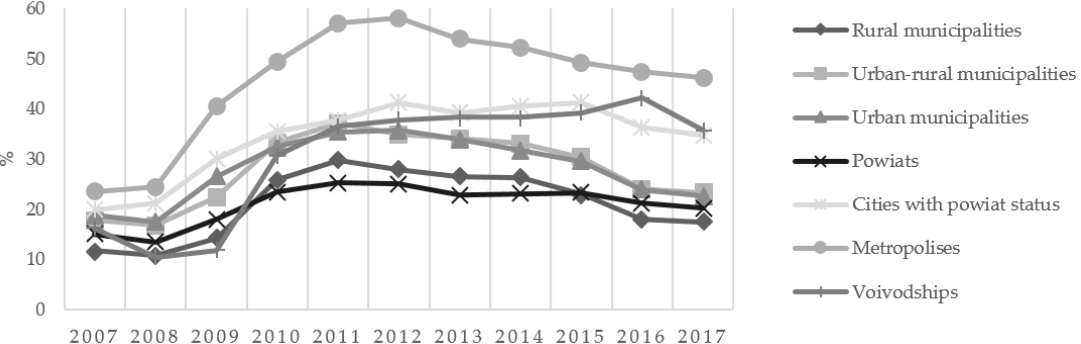
Figure 2. Ratio of total debt to total income in Polish local government units in 2007–2017 (%). Source: Own calculations based on data from the Ministry of Finance [35].